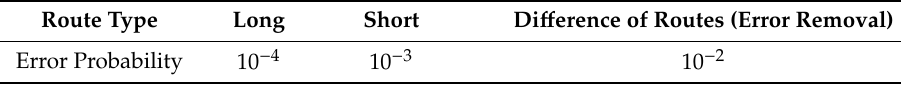
Figure 10. Error removal techniques. ( a ) Technique using difference of two routes to remove the systematic error. ( b ) Description of implementing the difference approach on the response of two routes of the FPGA. ( c ) Error probability curve after removal of the systematic error. Table 1. Error probability for di ff erent